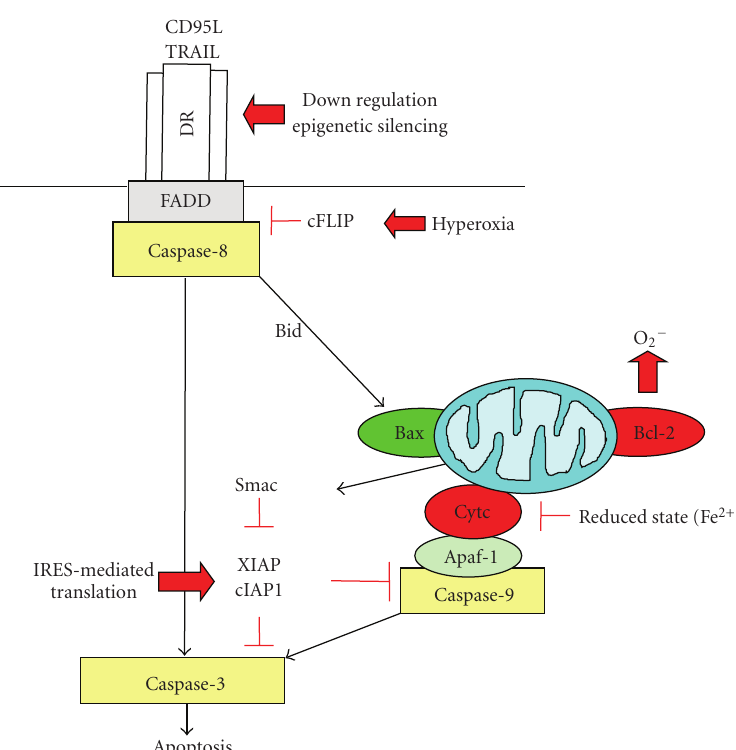
Figure 1: Interplay of cellular stress signals with apoptosis pathways. Signaling via the death receptor pathway can be inhibited by downregulation or epigenetic silencing of death receptors (DRs) or upregulation of cFLIP by hyperoxia. In the mitochondrial pathway, Bcl-2 favors a prooxidant milieu that promotes survival, while the reduced form of cytochrome c is inhibited in its activity to trigger caspase activation via the apoptosome. At the postmitochondrial level, translation of XIAP and cIAP1 is sustained via an IRES-dependent mechanism even under cellular stress conditions. See text for more